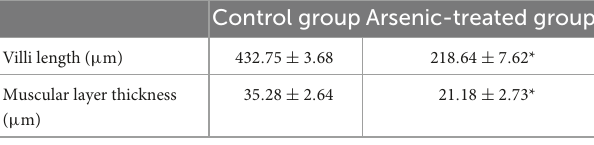
TABLE 2 Changes in the intestinal villi and muscular layer in distal intestinal tissues. Control group Arsenic-treated